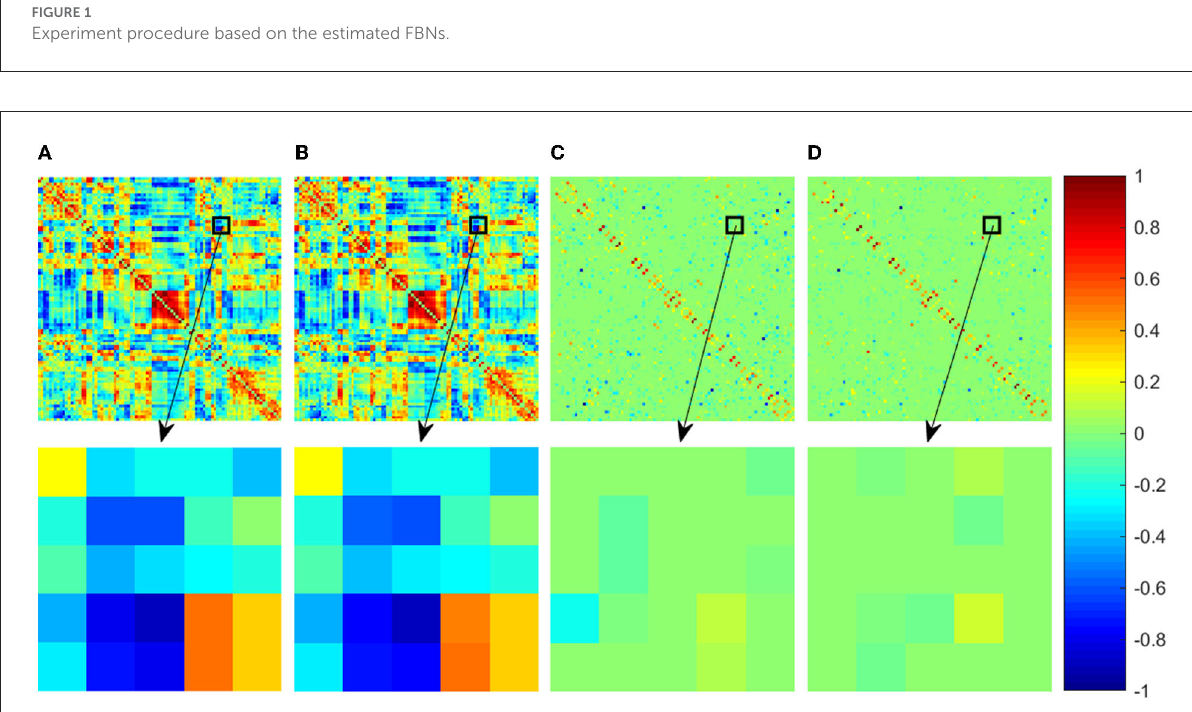
FIGURE2 Adjacency matrices of the FBNs estimated by four comparison methods. The first row shows the whole adjacency matrix and the second row shows the enlarged part corresponding to the black box in the first row. For a convenient comparison between the visualized results, the elements in the adjacency matrices have been normalized into the interval [ − 1,1]. (A) PC, (B) PCAND, (C) SR, and (D) SRAND.